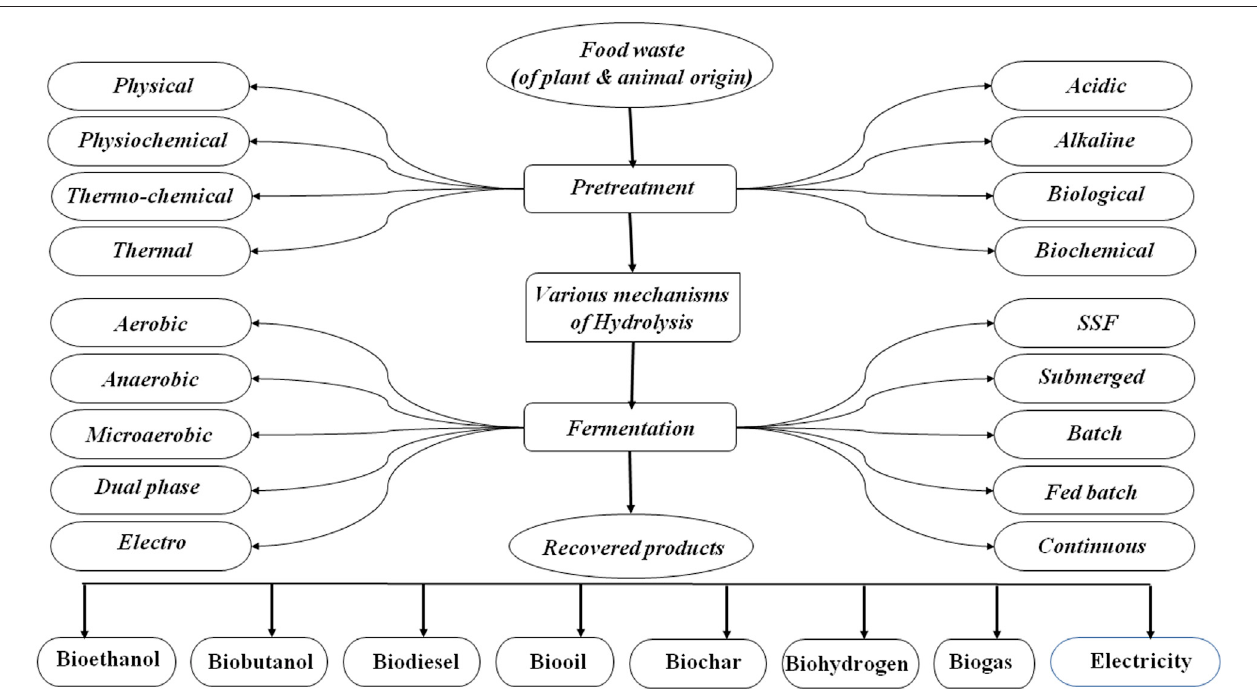
FIGURE 3 | A diagrammatic model of a FW-based biore fi nery from circular bioeconomy perspective.